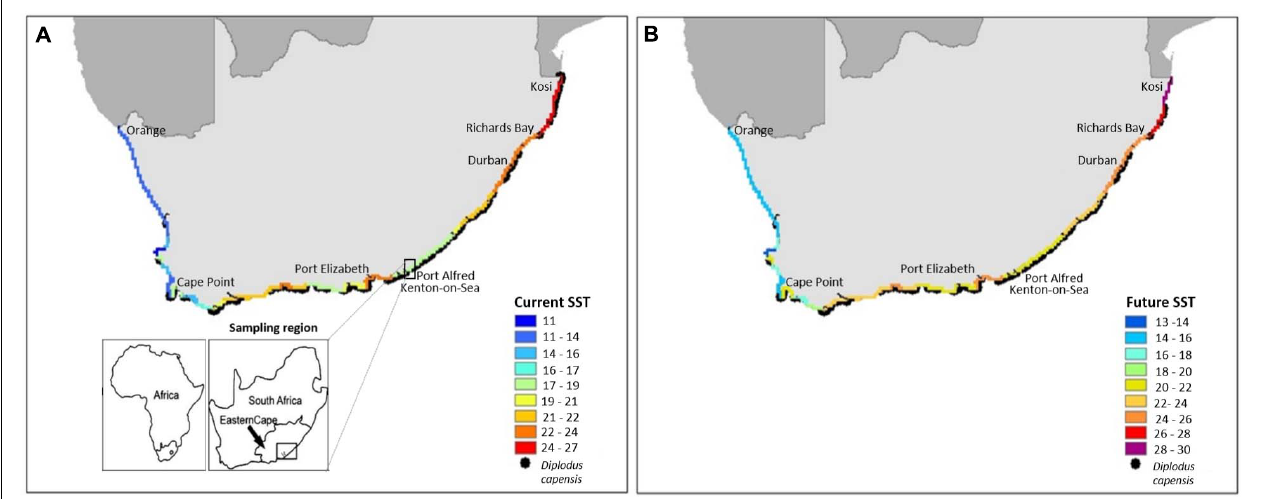
FIGURE 1 | (A) Recent mean February in situ coastal water temperatures for South Africa (from Smit et al., 2013) and the present known distribution of Diplodus capensis (https://portal.obis.org/taxon/273970); and (B) predicted mean February 2100 decadal coastal temperatures [0.2 ◦ C × 10 decades (from 2013) = 2 ◦ C in 2109; IPCC, 2014] and the predicted distribution of D. capensis based on an average T ARR thermal index of 28.3 ◦ C. Study region (Port Alfred surf zone and Kenton-on-Sea) in the Eastern Cape indicated by black outlined